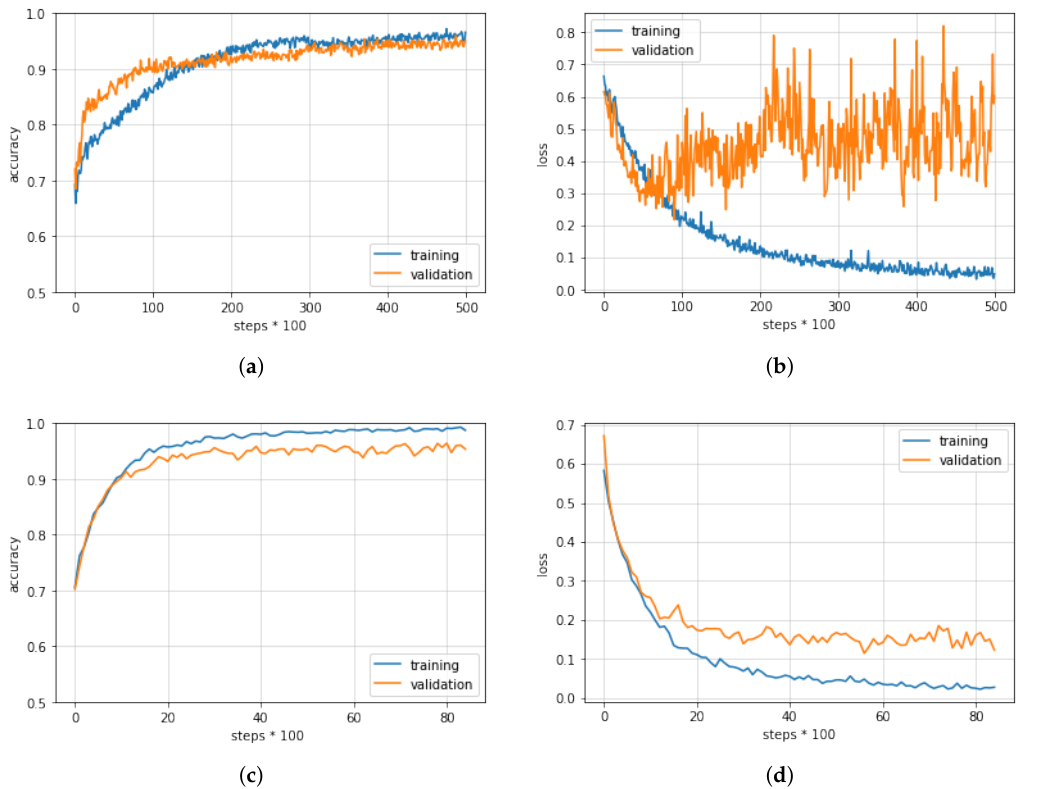
Figure 3. Comparison between the models with the lowest and the highest effectiveness for the training set and the validation set during fine-tuning. ( a ) VGG-16-B accuracy on Dataset-C. ( b ) VGG-16-B training and validation ( generalization ) error on Dataset-C. ( c ) ResNet-152-M accuracy on Dataset-OD. ( d ) ResNet-152-M training and validation error on